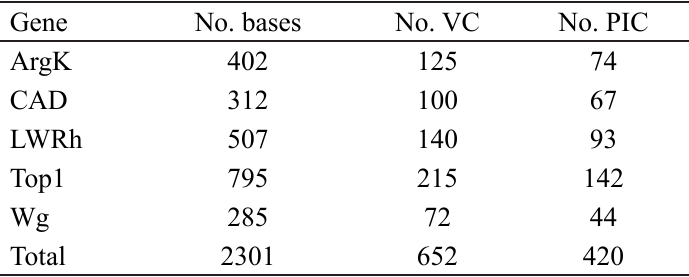
Table 2. Data on number of bases, number of variable characters (VC) and number of parsimony informative characters